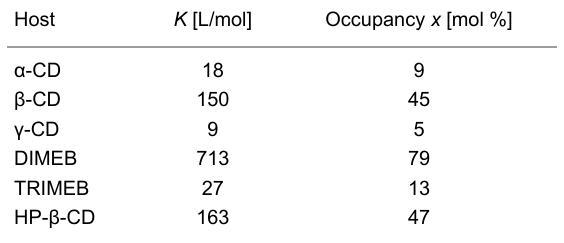
Table 2: Binding data for sevoflurane in native CDs and commercial CD derivatives at 25 °C.